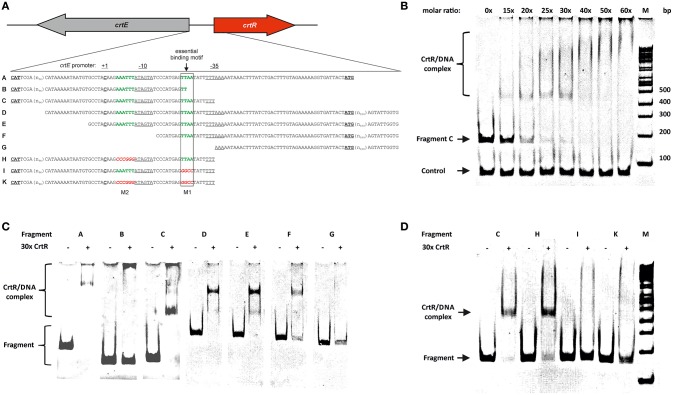
DNA-binding studies of purified CrtRHis6 protein with the 5′UTR of crtE. Promoter region of crtE/crtR and fragments used for electromobility shift assay (EMSA) (a). In green putative binding motifs (M1 and M2) are depicted and in red the respective mutations. The transcriptional start site of the crt-operon is depicted as C in bold (Heider et al., 2012). Fragment A represents the full length intergenic region of crtE and crtR including both translational starts (in bold letters). Fragment B,C,H,I, and K are shortened from the 3′ end, possessing either the original sequence (B, C) or mutations (H, I, K). Fragments D, E, F, and G were ‘successively shortened from the 5′ end and’ constructed with an extra 190 bp downstream of the crtR translational start codon. (b) EMSA with fragment C and different molar rations of purified CrtRHis6 from 0 (no protein added), 15, 20, 25, 30, 40, 50, and 60-fold molar excess. As a control the 5′UTR of cg2228 was used. (c) EMSA with 3′ (B, C) and 5′ (D, E, F, G) truncated fragments of the crtE-crtR intergenic region as depicted in a) and 30-fold molar excess of purified CrtRHis6. (d) EMSA with 3′ truncated fragment C and mutated fragments (H, I, K) and 30-fold molar excess of purified CrtRHis6.